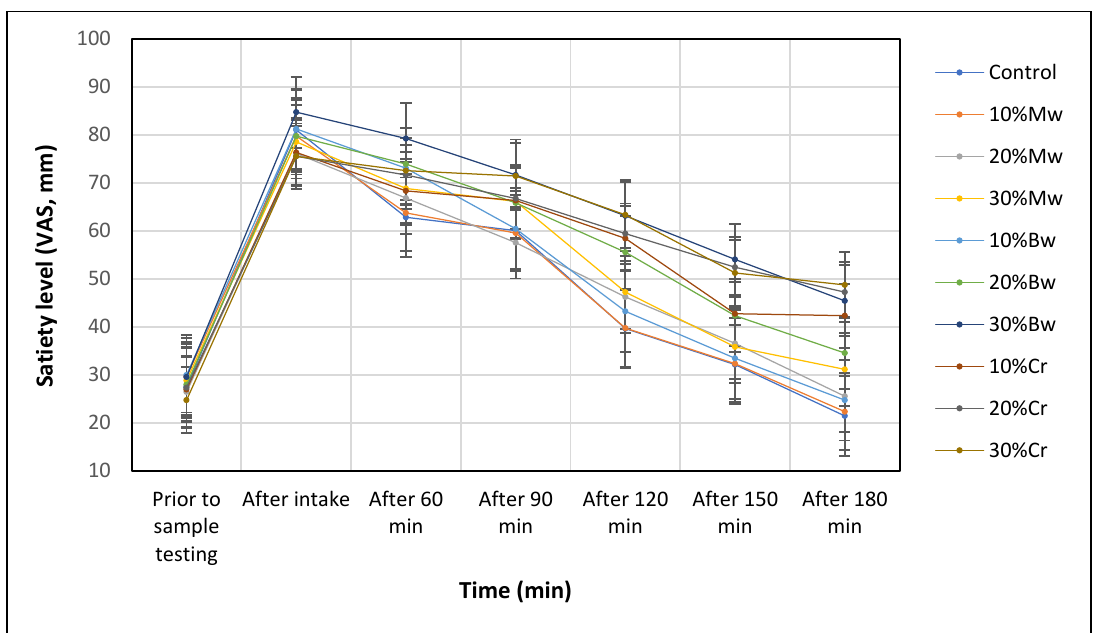
Figure 2. The determined satiety level after the ingestion of samples with the addition of edible insects for the entire study population.